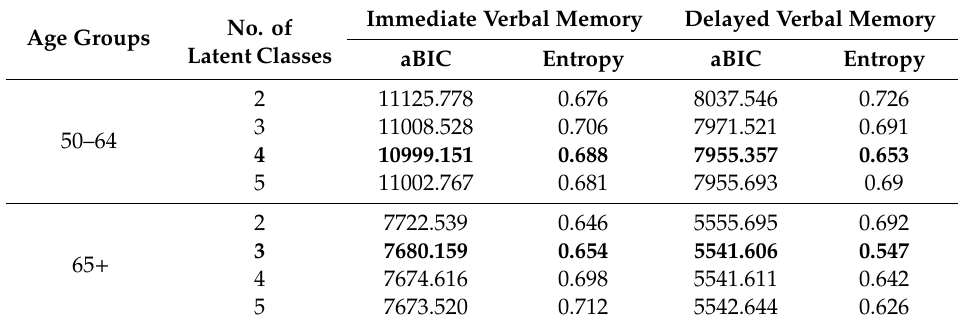
Table 2. Model comparison of immediate and delayed verbal memory according to adjusted Bayesian information criterion (aBIC) over individuals aged 50–64 and 65 +